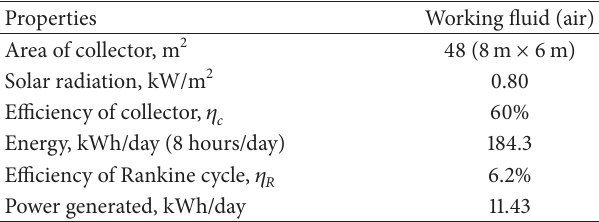
Table 2: Energy and outputs of the experimental